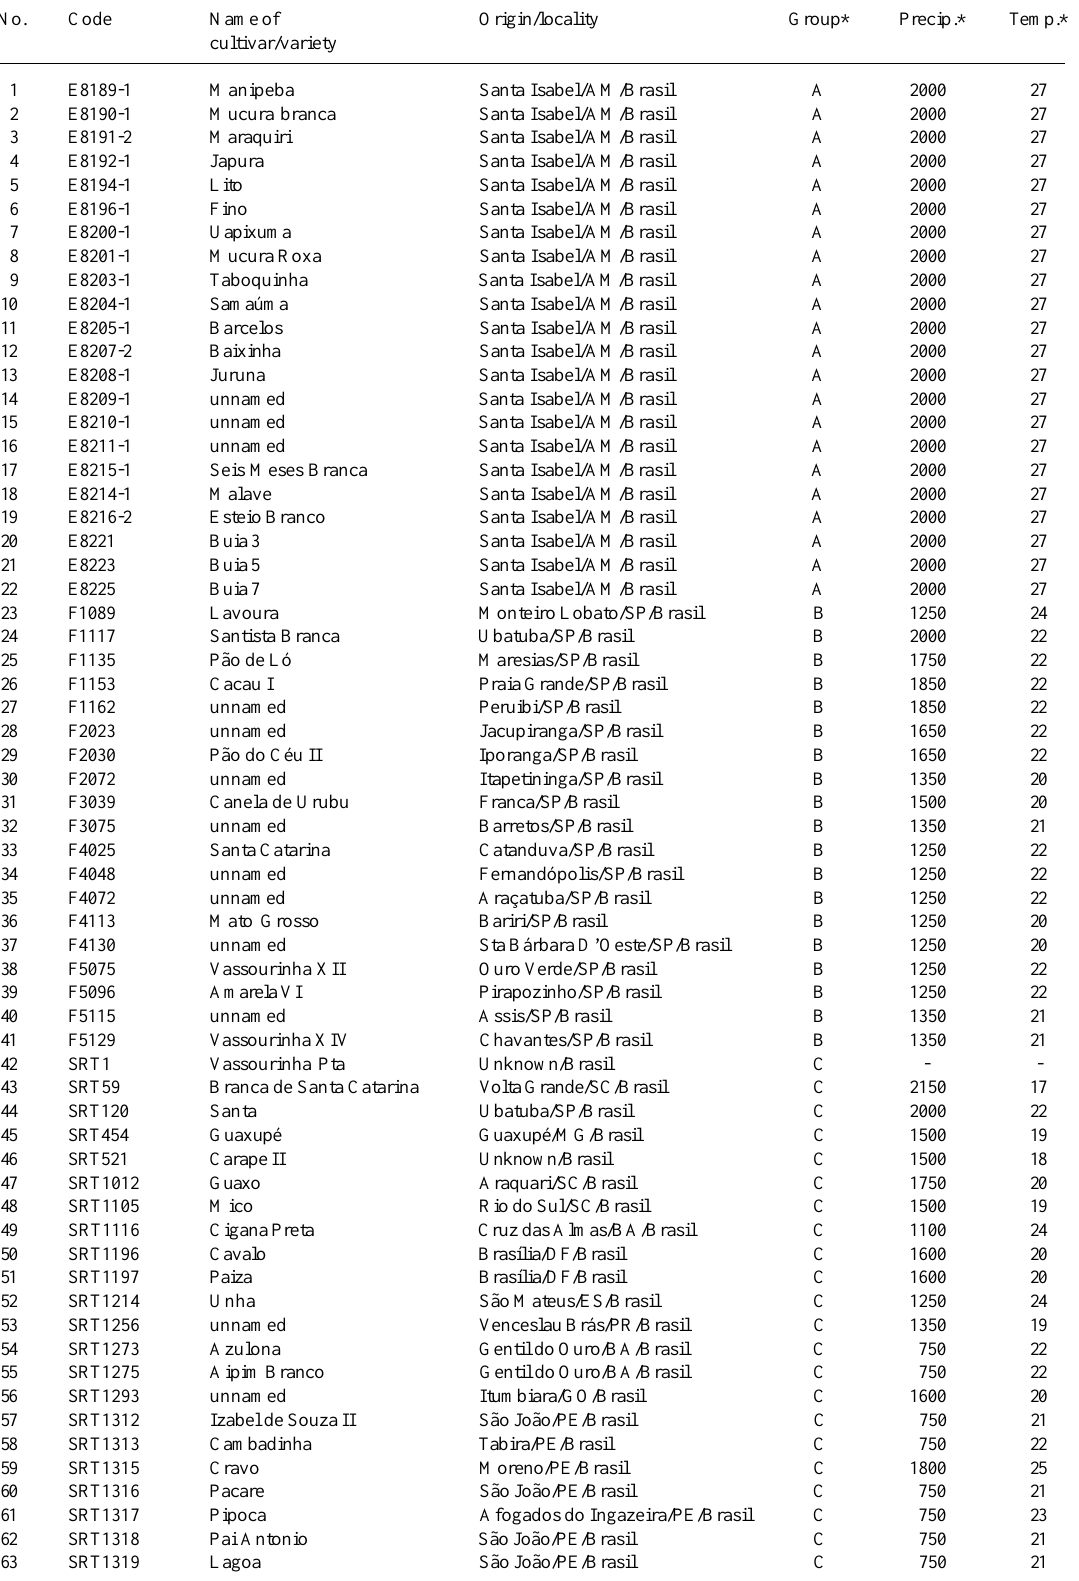
Table I - Plant samples used to investigate the genetic relatedness among cassava